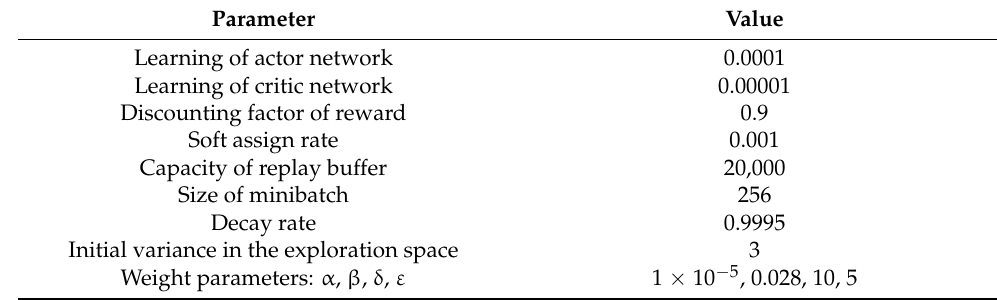
Table 2. Simulation parameter setting for autonomous car-following decision-making